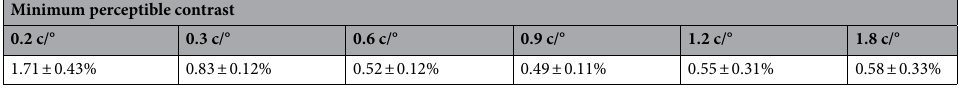
Table 4. Mean ± standard deviation of the minimum perceptible contrast obtained for each spatial frequency.